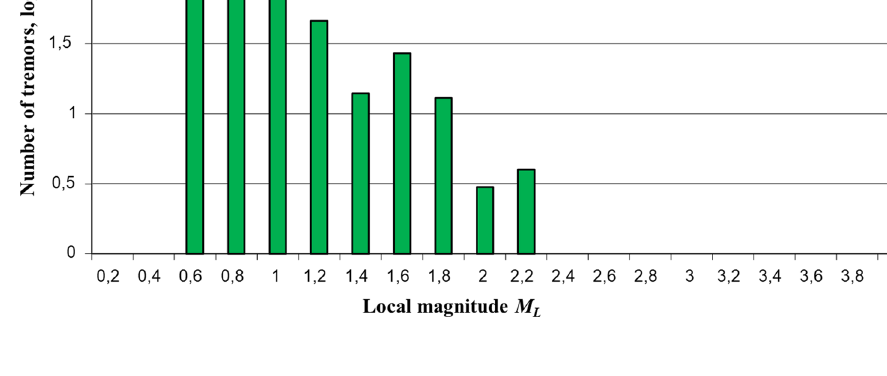
Table 2 Seismic hazard weight evaluation using the G-R law’s b parameter and the